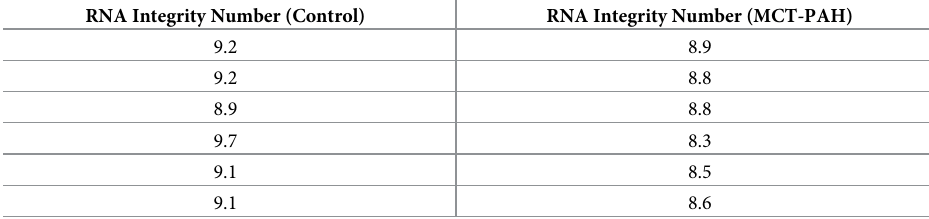
Table 2. Assessment of RNA quality by RNA integrity